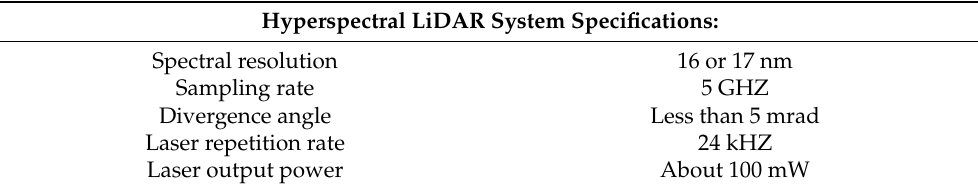
Table 1. Characteristics of the hyperspectral LiDAR prototype instrument.